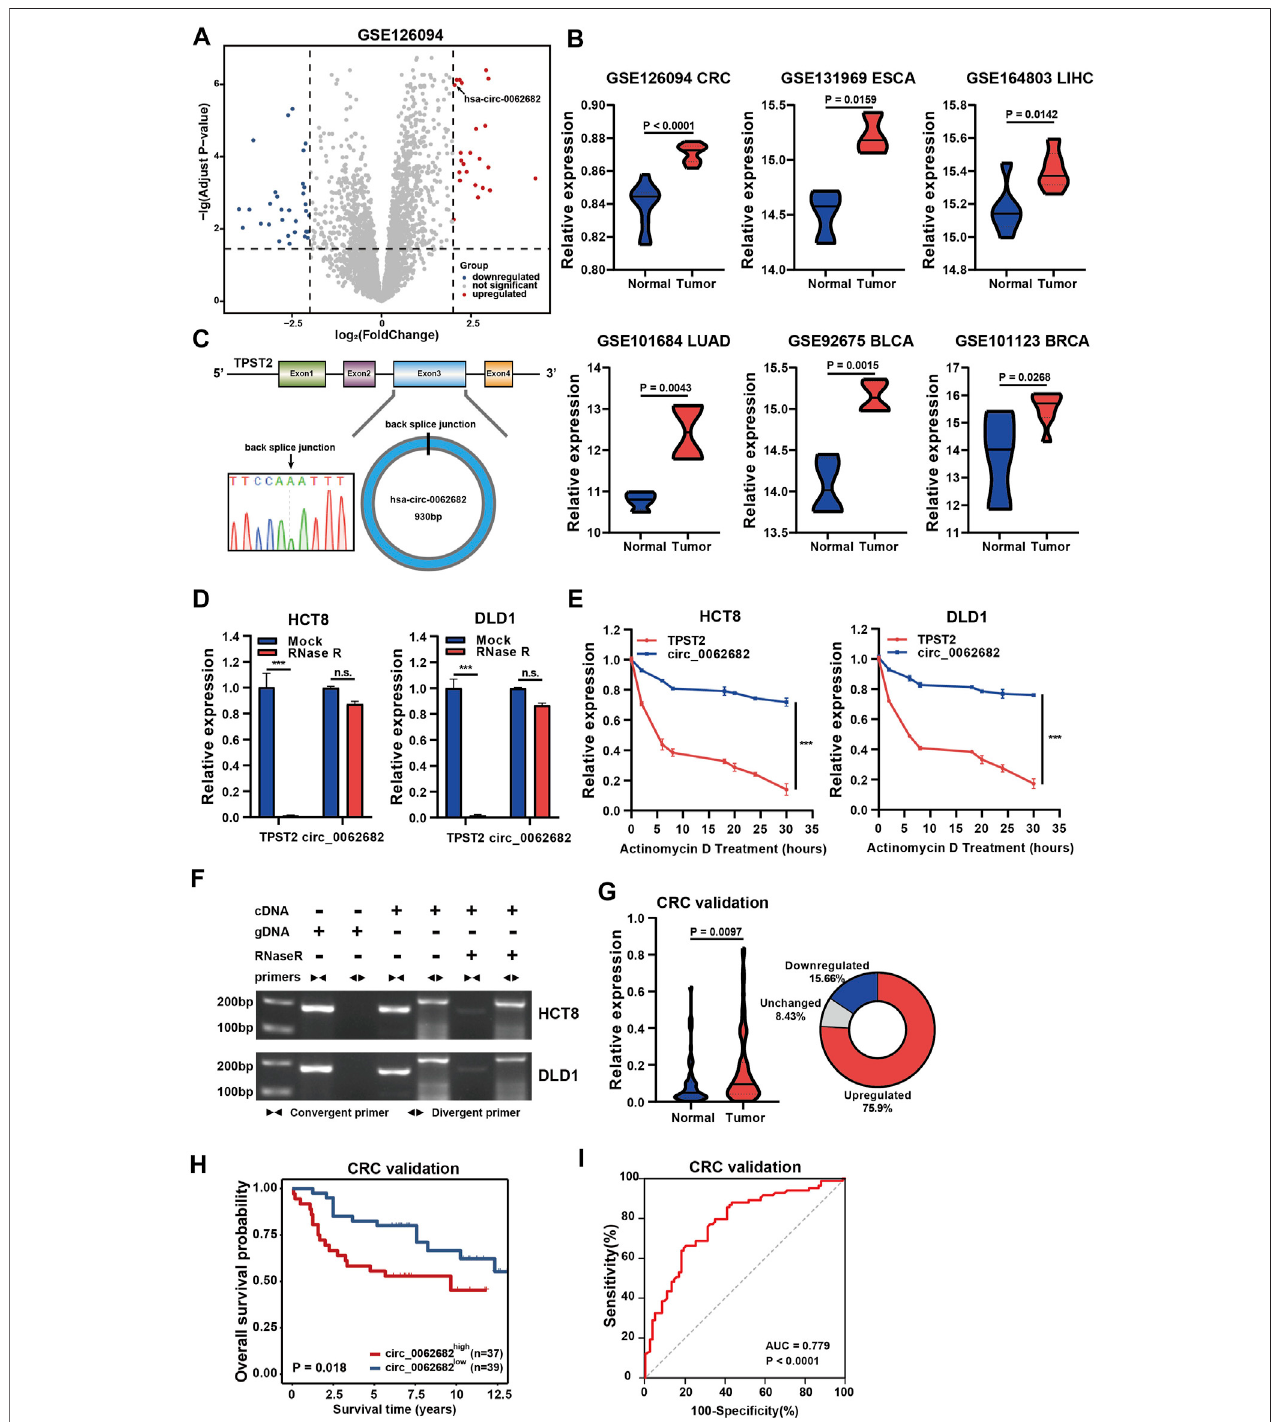
FIGURE 1 | Circ_0062682 is upregulated in CRC and correlated with poor prognosis. (A) Volcano plots of differentially expressed circRNAs in CRC vs normal samples. The red points indicate the statistically upregulated circRNAs, the blue points indicate downregulated circRNAs, and the gray points indicate no signi fi cant circRNAs. (B) Circ_0062682 is upregulated in multiple cancer types based on the analyses of multiple GEO datasets. (C) The back splicing site of circ_0062682 was con fi rmed by Sanger sequencing. (D,E) The abundances of circ_0062682 and TPST2 were determined using qRT-PCR in HCT8 and DLD1 cells treated with RNase R (D) and actinomycin D (E) . (F) The existence of circ_0062682 in CRC cells was validated by RT-PCR with convergent and divergent primers. (G,H) Circ_0062682 was signi fi cantly upregulated in CRC tissues (G) and correlated with poor prognosis (H) . (I) The expression of circ_0062682 differentiated CRC tissues from paired normal tissues using a ROC method. * p < 0.05; ** p < 0.001; *** p < 0.001.